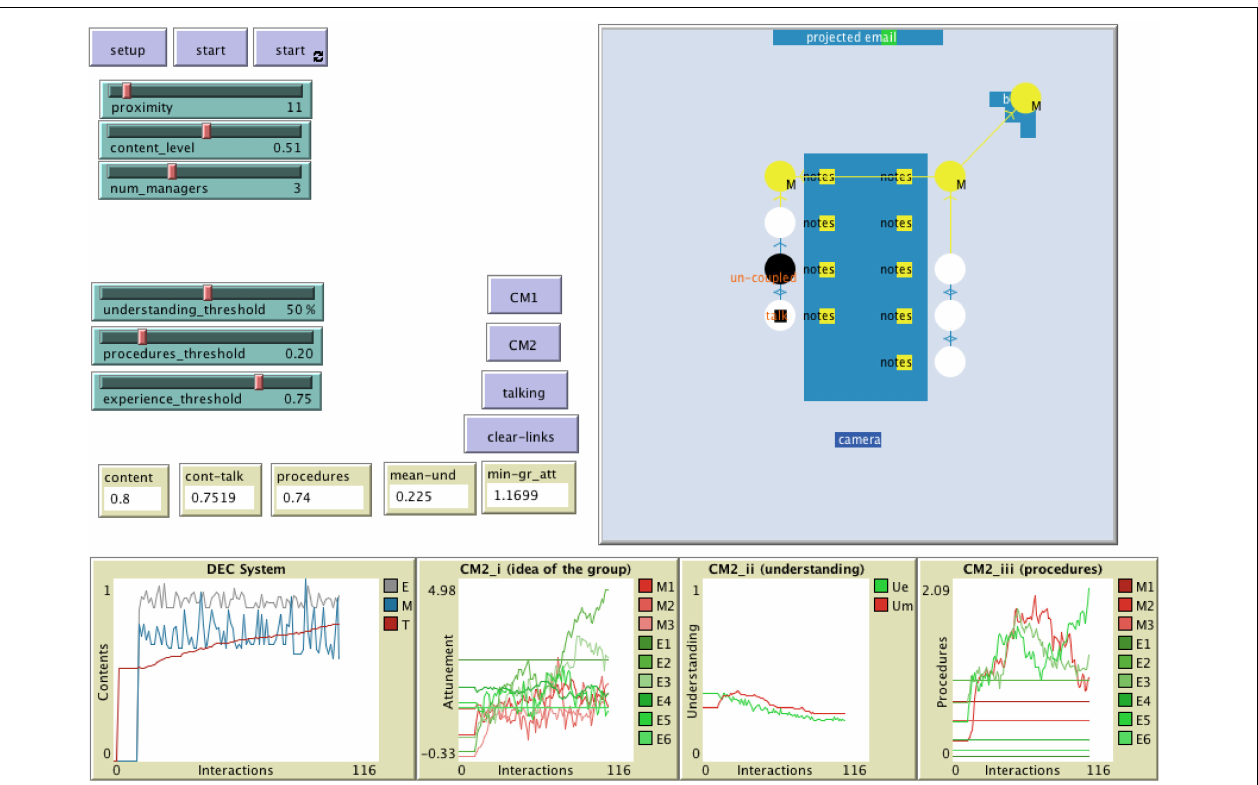
FIGURE 4 | NetLogo interface: the base example. The interface presents the end result of a model where couplings from the various cognitive mechanisms (CM1 and CM2) are set to replicate the outcome of the meeting—i.e. agreement on one item of the agenda—, after 100